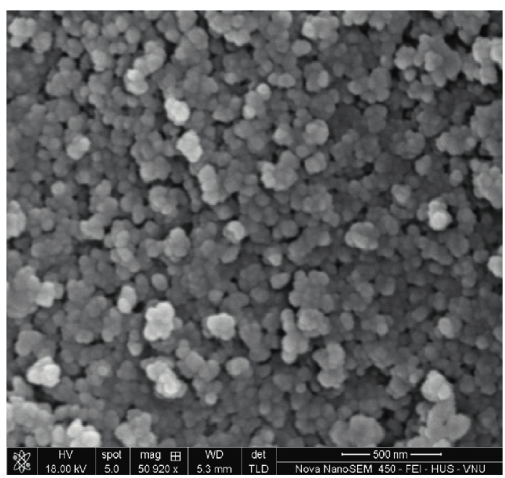
Figure 1: The SEM of the MaF